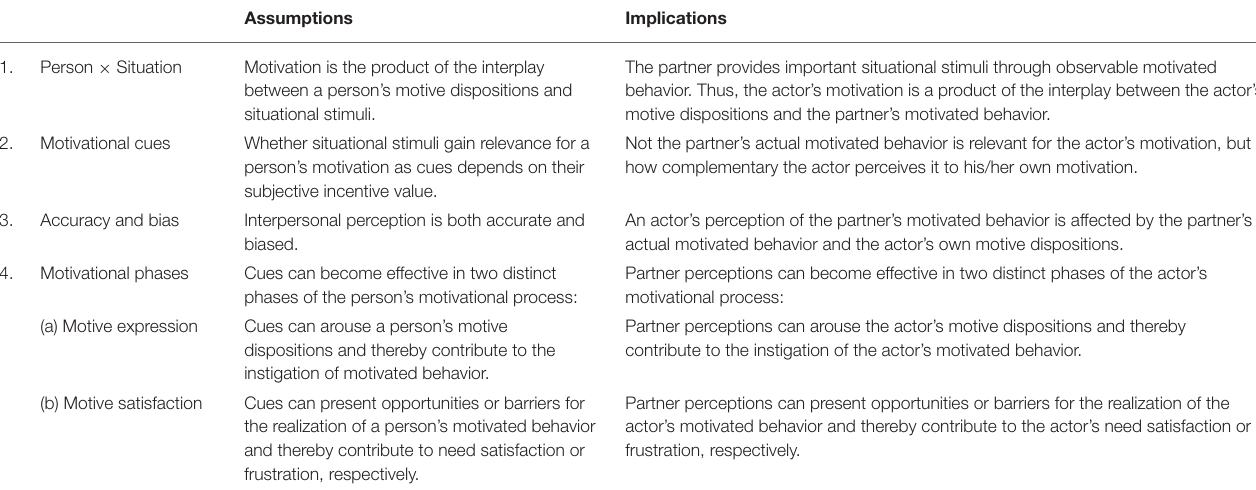
TABLE 1 | Theoretical assumptions and their implications for motivational interdependence in couple